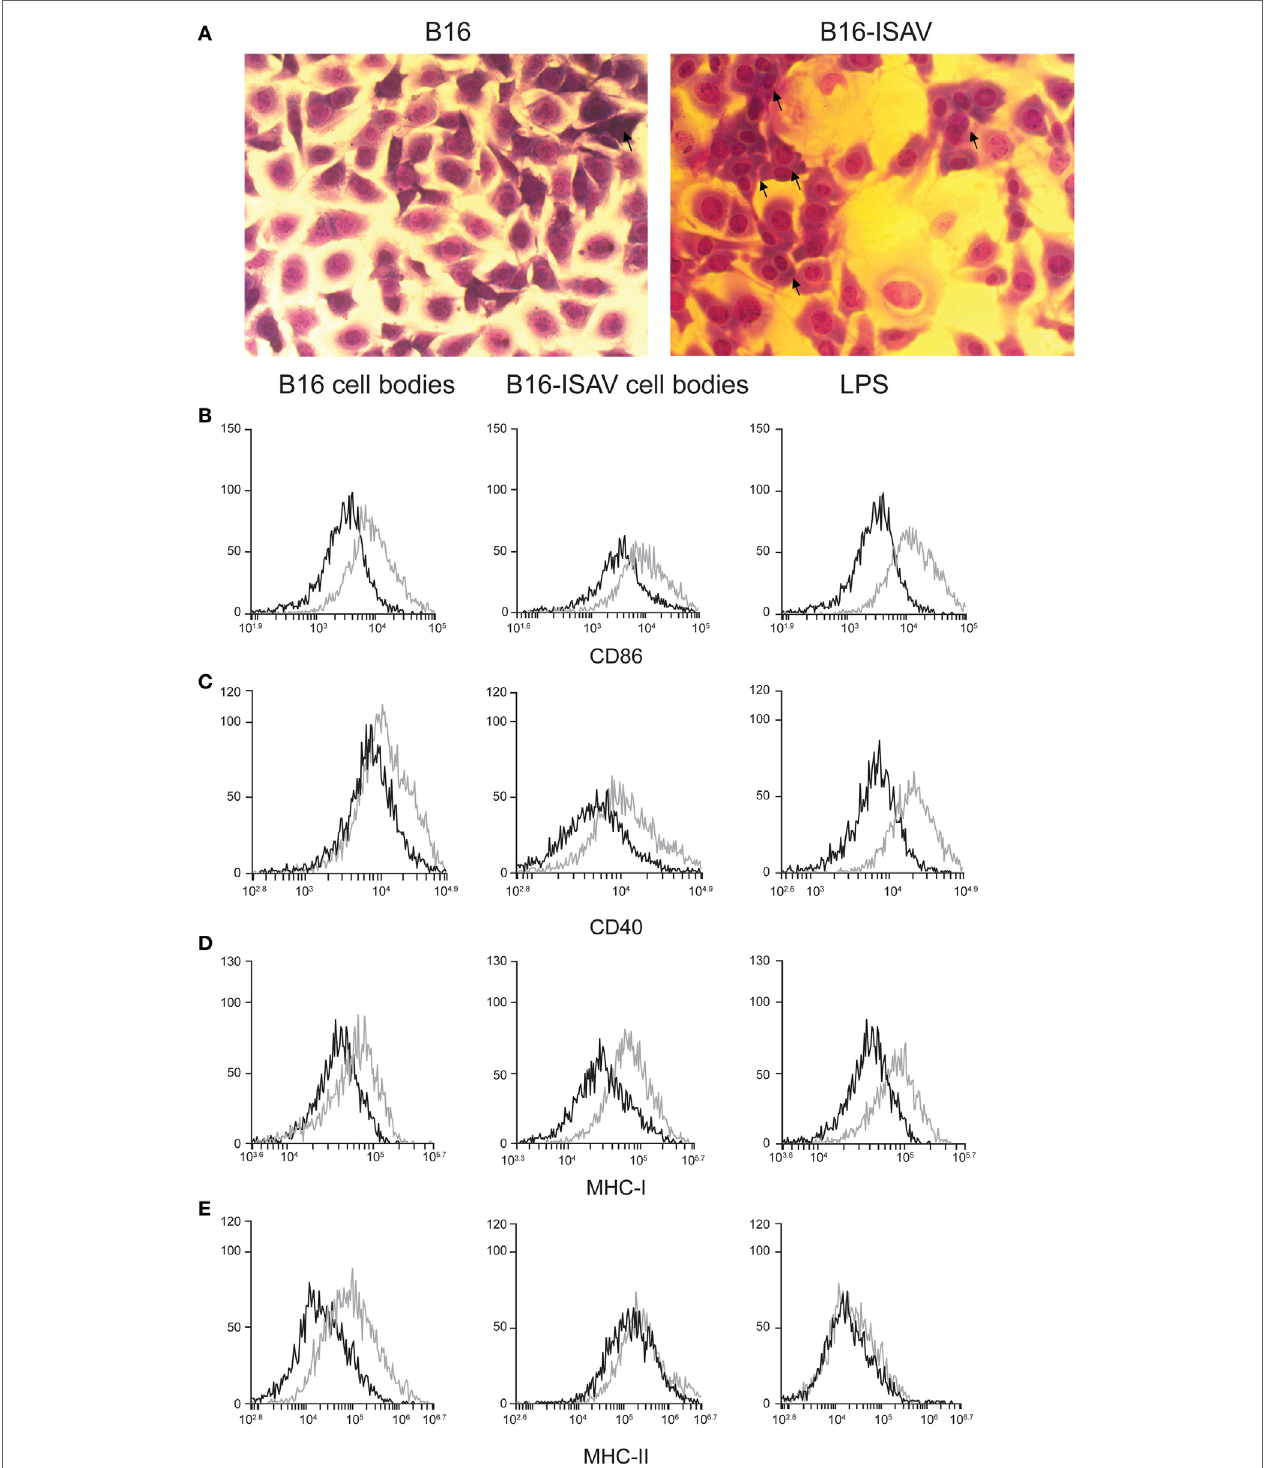
FigUre 4 | Fusion protein infectious salmon anemia virus (ISAV) induces fusion in B16, and cell bodies (CBs) derived from B16 and B16-ISAV induce dendritic cell maturation. (a) Cell fusion was evaluated by transmitted light microscopy and hemacolor stain in non-transfected and ISAV-transfected cells B16 (arrows indicate fused cells). The expression of maturation markers determined by the percentage of (B) CD86 and (c) CD40 positive cells, and by the mean fluorescence intensity for (D) MHC-I and (e) MHC-II, induced by CBs was measured in dendritic cells by flow cytometry. Representative histograms of the ratio 1:1 (CBs/DCs) of dendritic cells stimulated with B16 and B16-ISAV bodies (control, black line; stimulated, gray